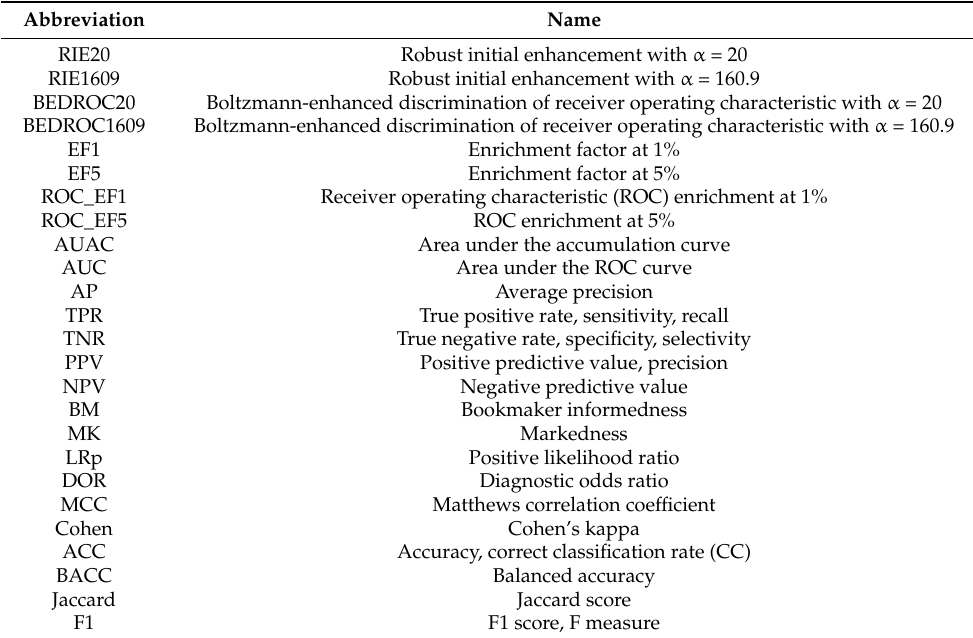
Table 3. Summary of the applied performance